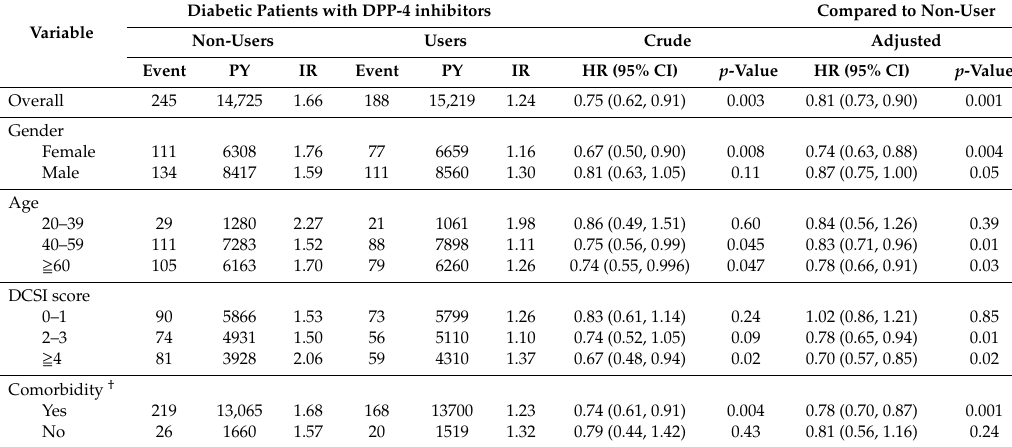
Table 2. Incidence rate and hazard ratio of allergic rhinitis in diabetes patients of DPP-4 inhibitor users compared to non-users.